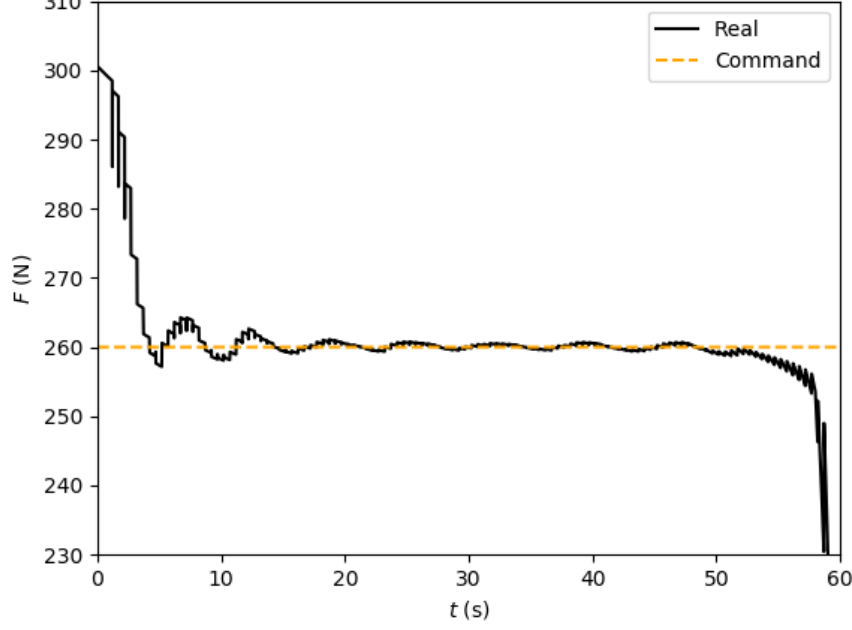
Figure A5. Thrust profile, feedback with downgraded regulation law, case 1.